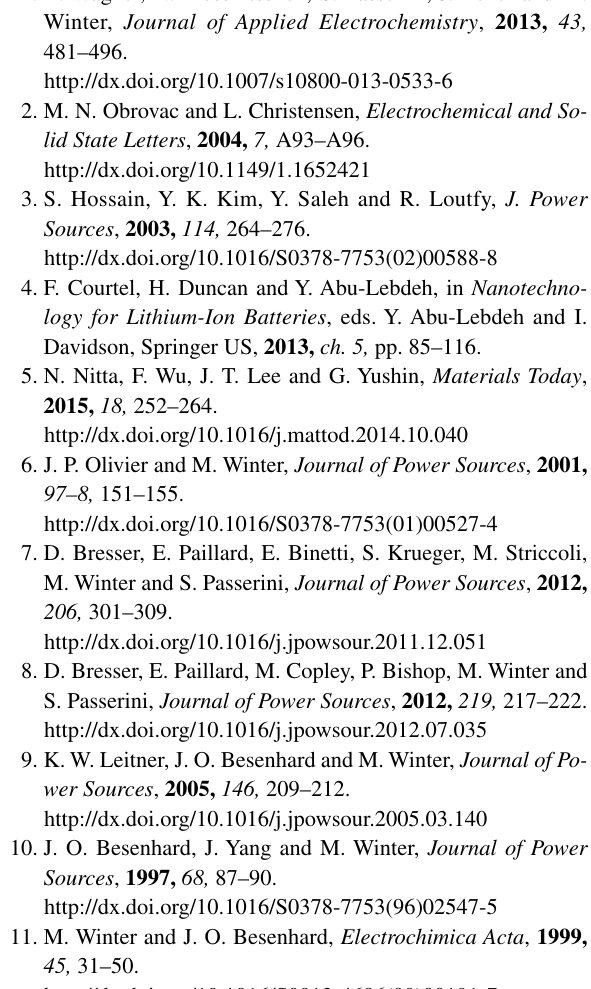
O /C (0.1C), Si/graphite (0.1C) and graphi- 2 4